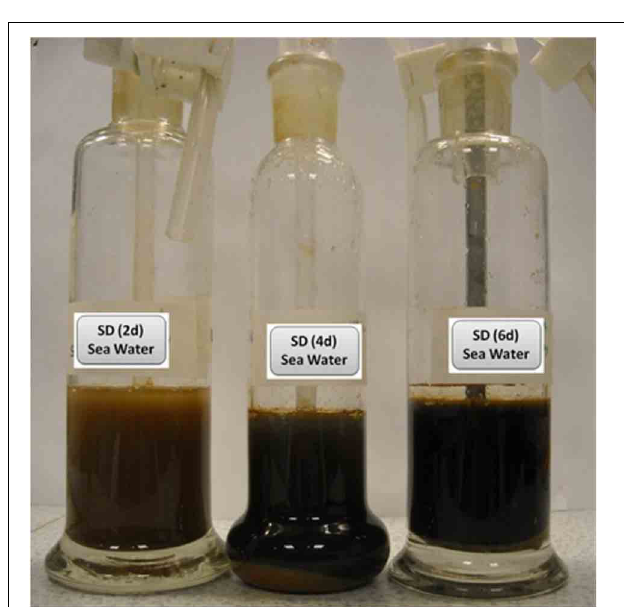
FIGURE 2 | Drechsler bottles showing no distinct color change across all treatments until the second day of incubation. GS , G. sulfurreducens ; SD , S. denitrificans .